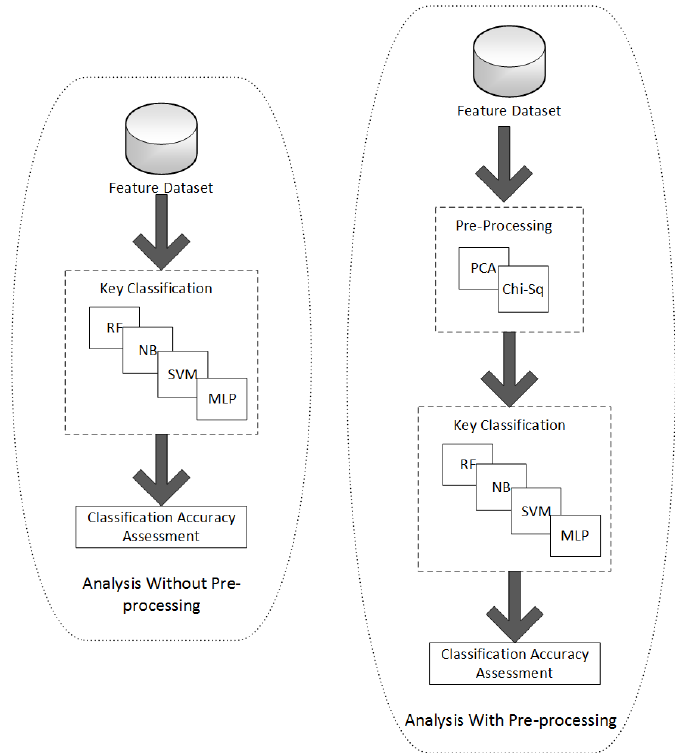
Figure 6. Classification process without pre-processing ( left ) and with pre-processing ( right